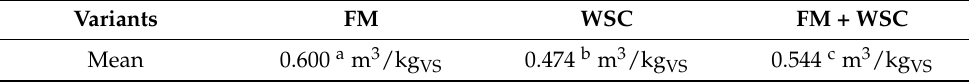
Legend to Table 7: Different small letters illustrate demonstrable differences between the respective experimental treatments at a level of significance p < 0.05. FM—fodder mallow, WSC—white sweet clover.